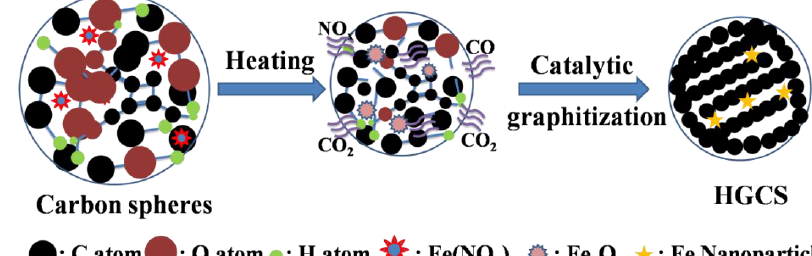
Figure 10. Formation mechanism of HGCS in the case of using Fe catalyst.